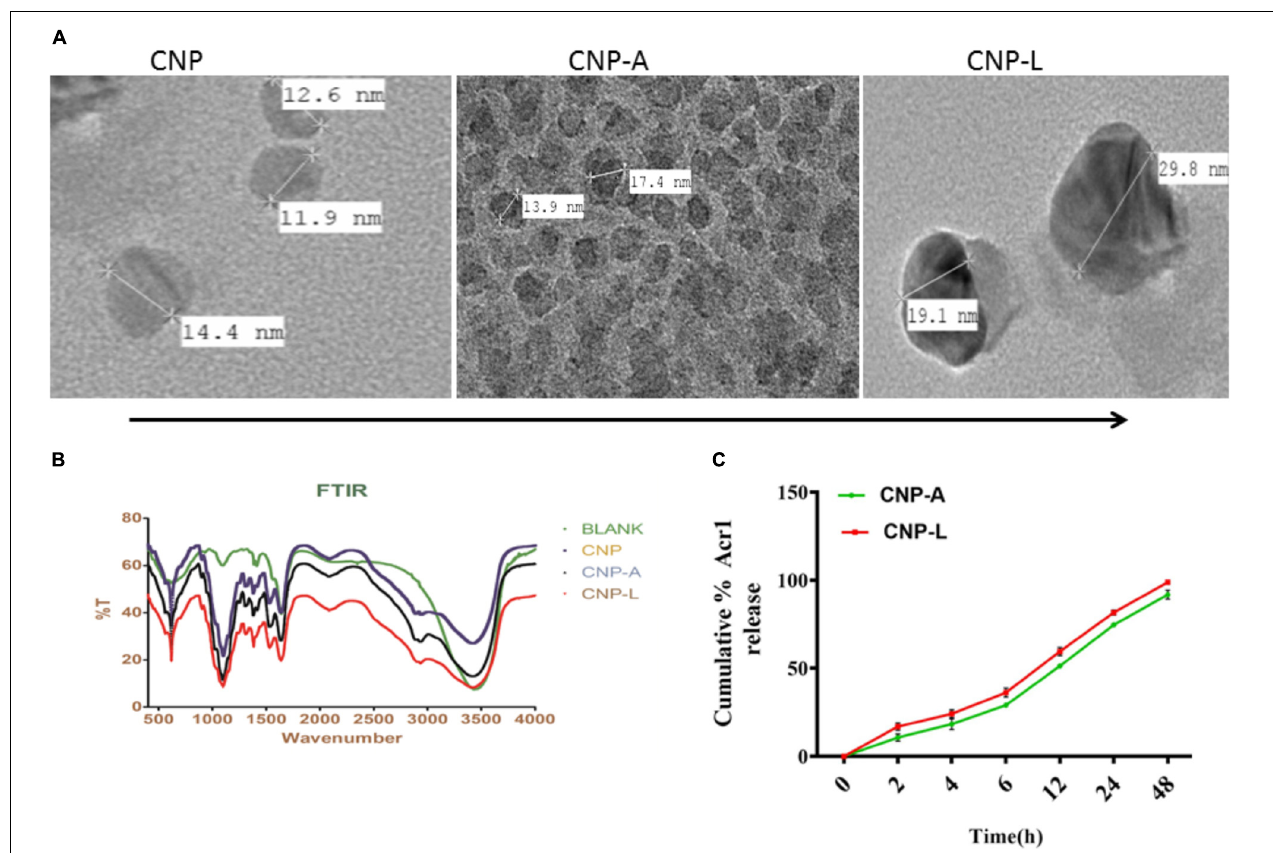
FIGURE 1 | (A) Physical characterization of as-synthesized CNPs. Transmission electron microscopic images of CNP, CNP-A, and CNP-L (CNPs) nanoparticles (scale bar; 100 nm). (B) Fourier transformation infrared microscopy of CNPs (polydispersion index and zeta potential of CNPs as determined by Malvern Zeta Sizer). (C) Acr-1 antigen release from CNP-A/CNP-L nanoparticle at stipulated